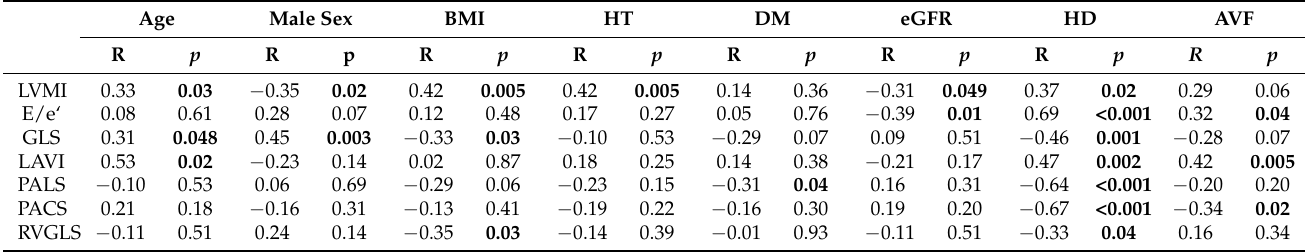
Figure 1. Examples of strain curves illustrating LV ( A ) and LA ( B ) function in HD ( upper panel) and preemptive KTx patients ( lower panel) obtained from the apical four-chamber view. Higher values of LV strain (24.8% vs. 11.3%; red arrows), PALS (36.7% vs. 15.1%; yellow arrows), and PACS (16.7% vs. 10.2%; green arrows) were found in patient from the preemptive KTx group. Table 3. Associations of cardiac functional and morphological parameters with demographic and clinical characteristics: univariate